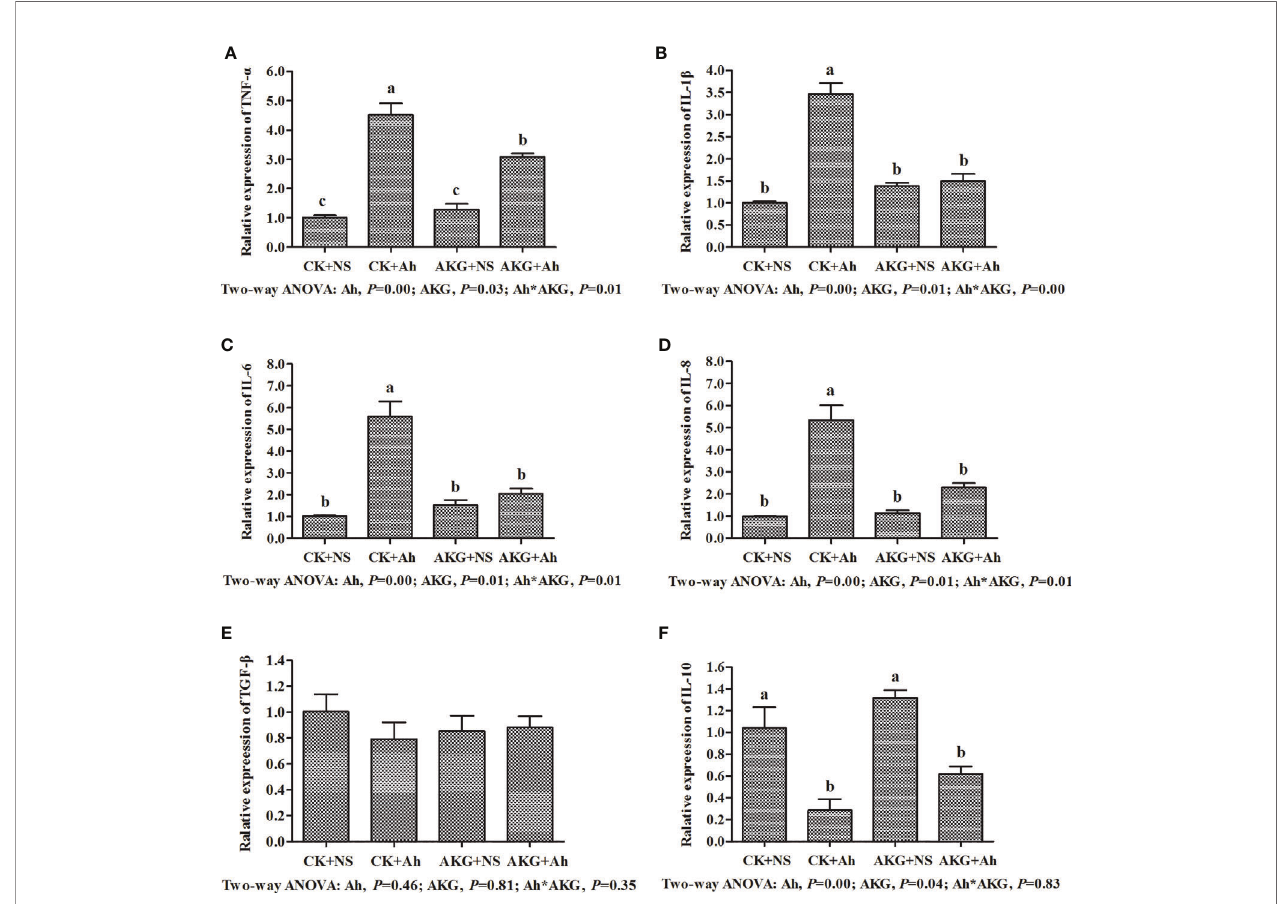
FIGURE 5 | Effects of AKG supplementation and A hydrophila infection on relative mRNA expression levels of immune-related TLR4/MyD88/NF- k B signaling pathways of Songpu mirror carp ( Cyprinus carpio ). (A) TNF- a , tumor necrosis factor- a ; (B) IL-1 b , interleukin-1 b ; (C) IL-6, interleukin-6; (D) IL-8, interleukin-8; (E) TGF- b , transforming growth factor- b ; (F) IL-10, interleukin-10. All of the values are expressed as the means ± SEM. Values with different letters are signi fi cantly different ( P <